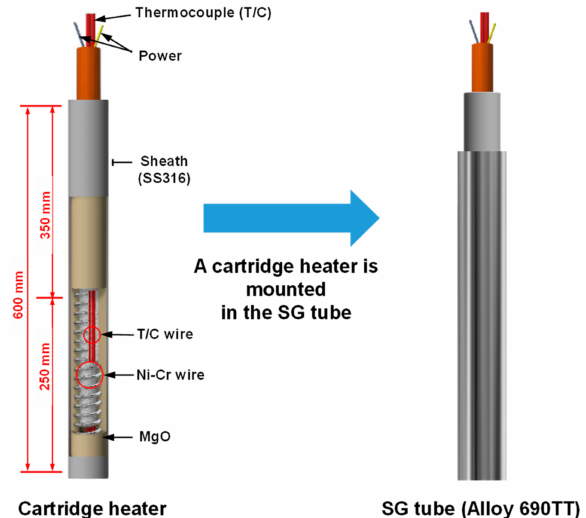
Figure 2. Design of cartridge heater and heater-mounted SG